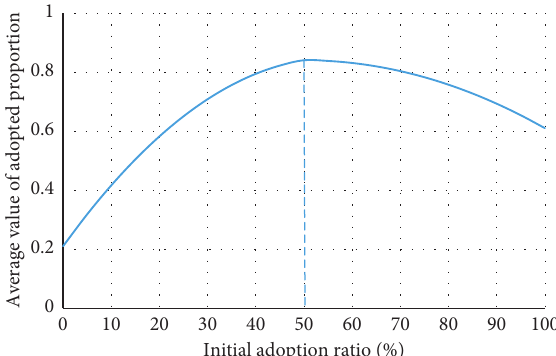
Figure 19: Optimal solution